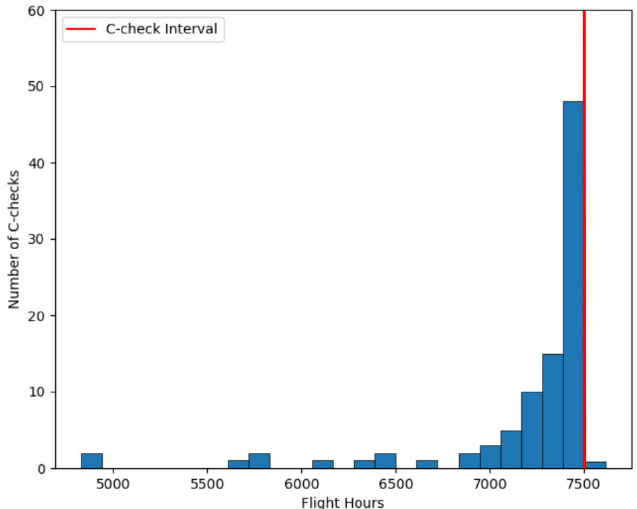
Figure 4. Distribution of C-check